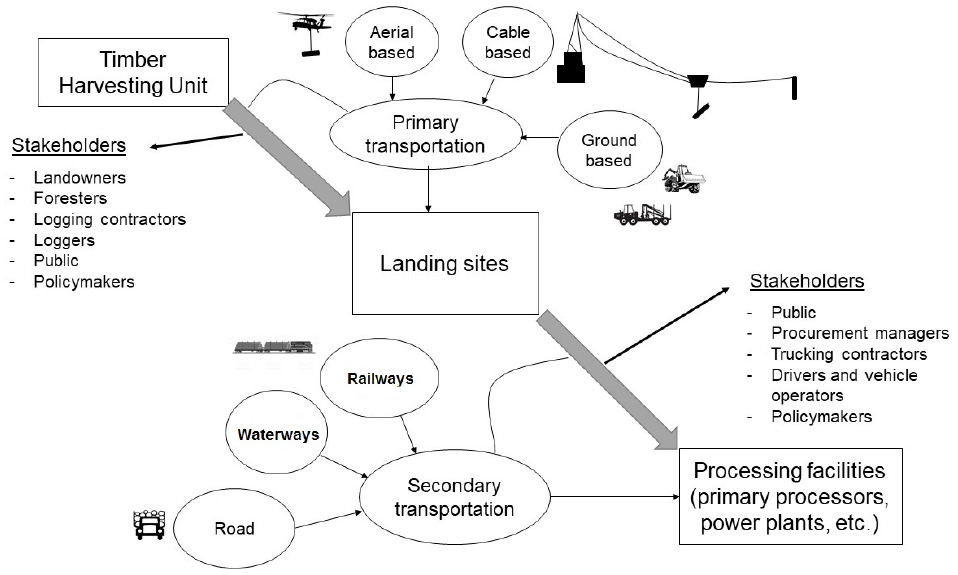
Figure 1. A sketch showing the flow of raw forest products from timber harvesting unit to the processing facilities like mills, powerplants, and industries. For this study, the focus, however, will be on the transportation from landing sites to the processing